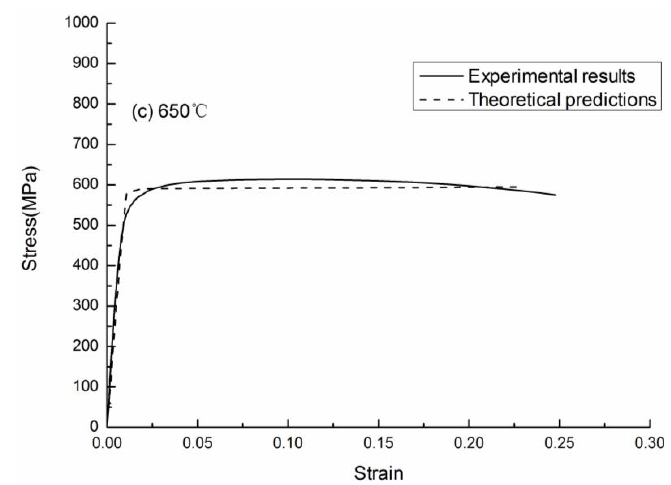
Figure 4. Comparisons of stress-strain curves of TiC/TMCs composites with the theoretical results and test results at different temperatures: ( a ) 300 °C; ( b ) 560 °C; and ( c ) 650 °C.